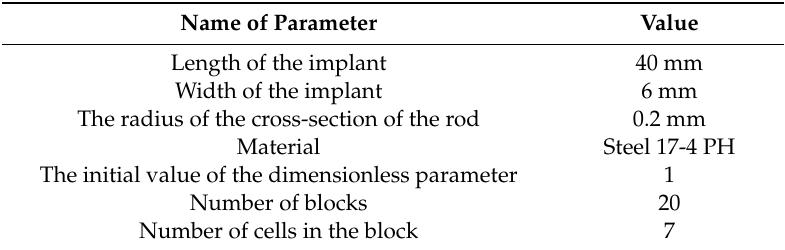
Table 1. Geometric and mechanical